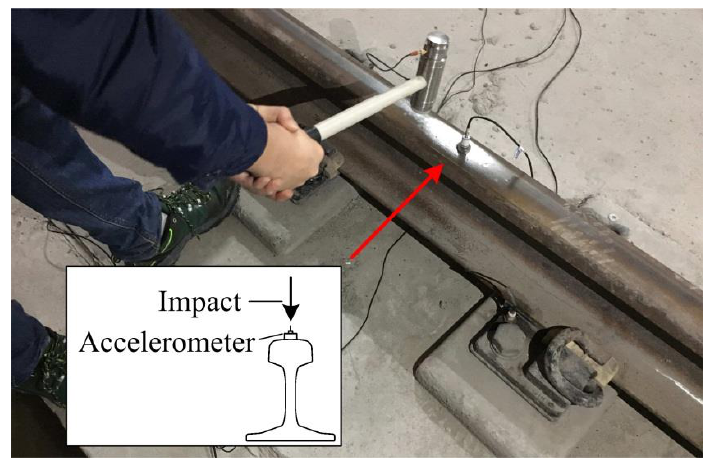
Figure 8. The field measurement of the rail accelerance.